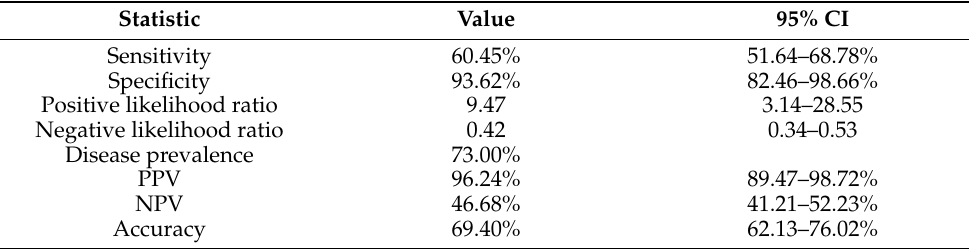
PPV—Positive predictive value; NPV—Negative predictive